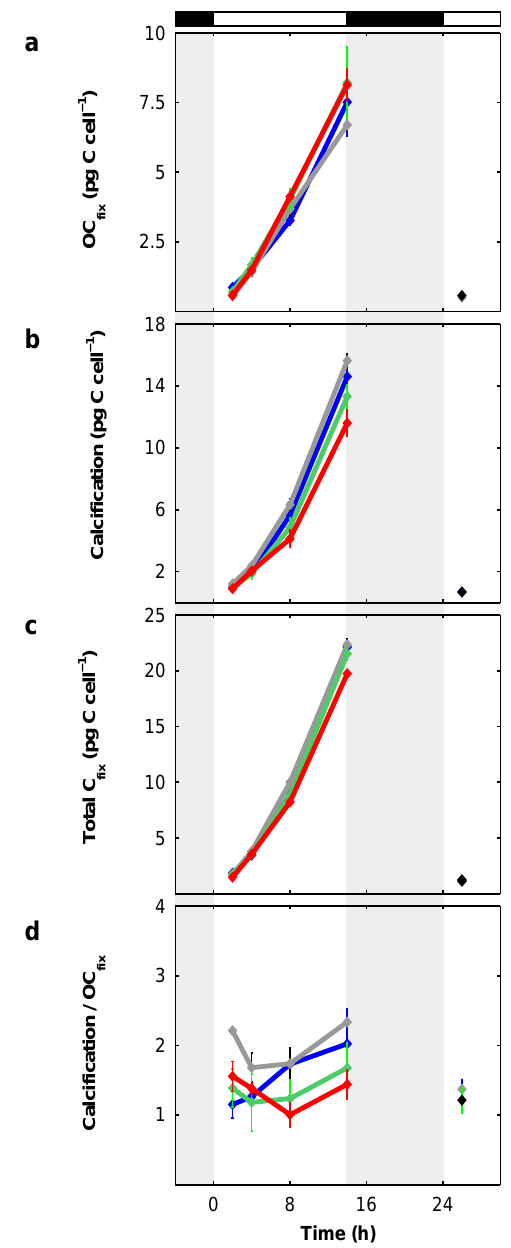
Fig. 1. Cumulative carbon fixation of Emiliania huxleyi through time. (a) organic carbon fixation per cell, (b) calcification per cell, (c) total carbon fixation per cell and (d) ratio between calcification and organic carbon fixation. 190µatmCO 2 (blue), 410µatmCO 2 (grey), 800µatmCO 2 (green), 1500µatmCO 2 (red). Data from the 26h considers only a 2h incubation period. Each CO 2 level has duplicate measurements. Vertical error bars represent the range of the data and the lines connect the averages of each time point. The white/black bar on top represents the light/dark diel cycle, vertical grey bars denote the dark